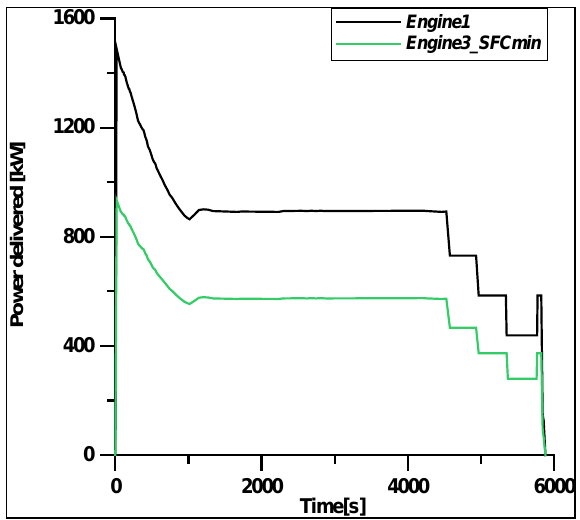
Figure 17. Power vs time of the Engine_3.